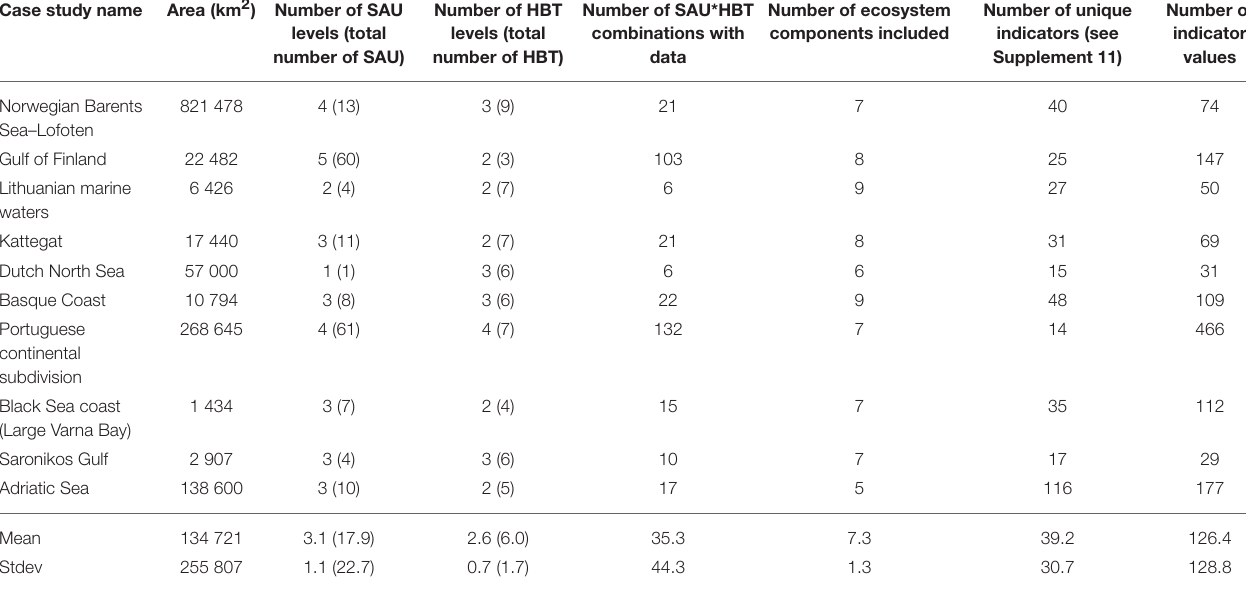
Number of HBT Number of SAU*HBT Number of ecosystem levels (total levels (total combinations with components included number of SAU) number of HBT) data